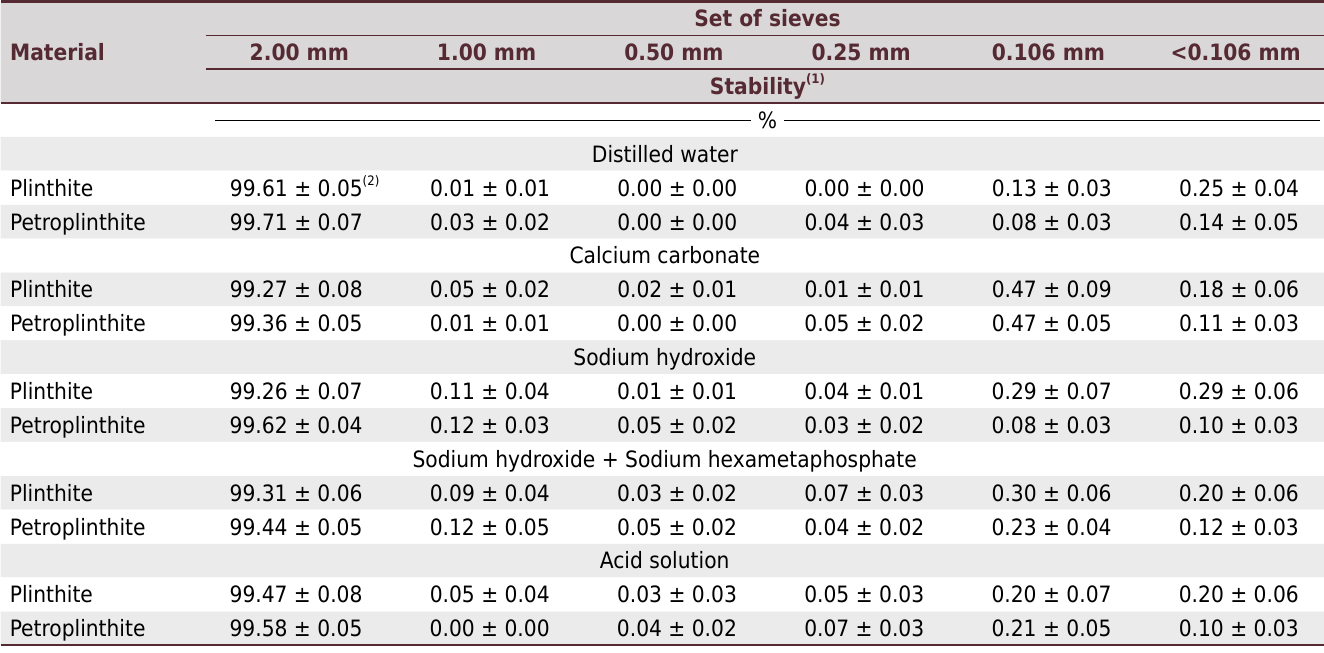
Table 6. Mean value and standard error of the mean stability of the plinthite and petroplinthite subsamples in the soil profiles, immersed in different solutions